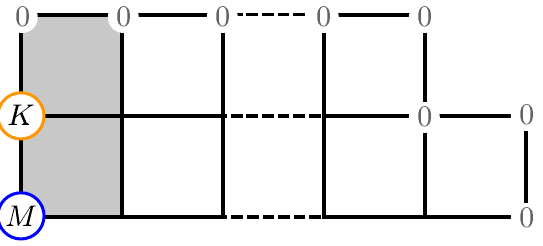
Figure 9 . The Young tableaux with two rows. The (cid:12)rst row has K boxes and the second row has M (cid:0) K